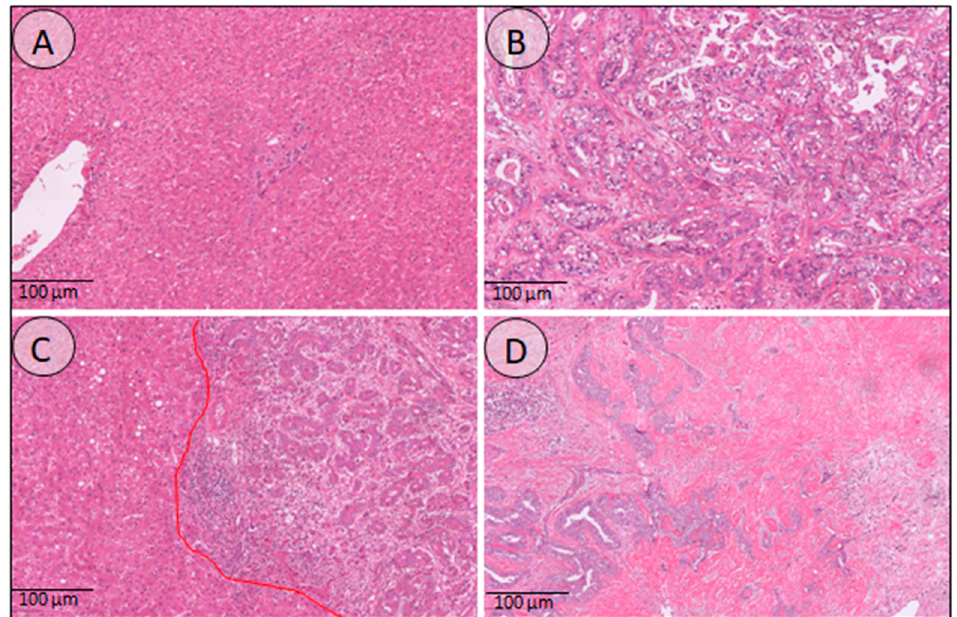
Figure 3. Histology overview of the different annotated regions. ( A ) Normal liver tissue, demonstrating liver parenchyma, portal tracts, and a central vein. ( B ) Tumor region consisting of atypical tumor glands and little desmoplastic stroma in between. ( C ) This image demonstrates the interface region, where the tumor glands grow into the surrounding liver tissue. ( D ) The sclerotic tumor here shows an abundance of dense stroma with just a few tumor glands in between.